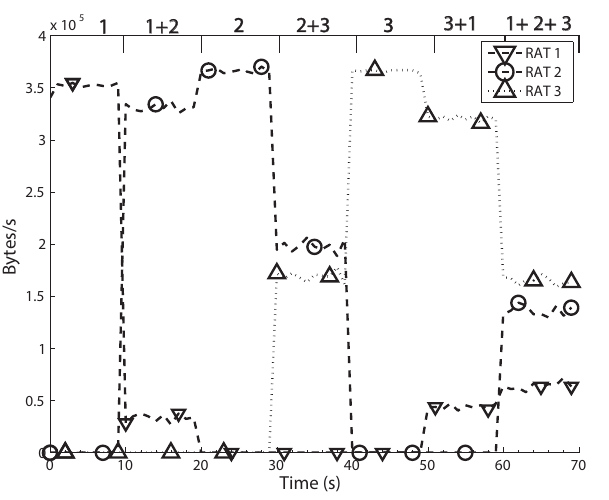
Figure 8. RAT Distribution Scenario Figure 9. Packet Delivery Ratio